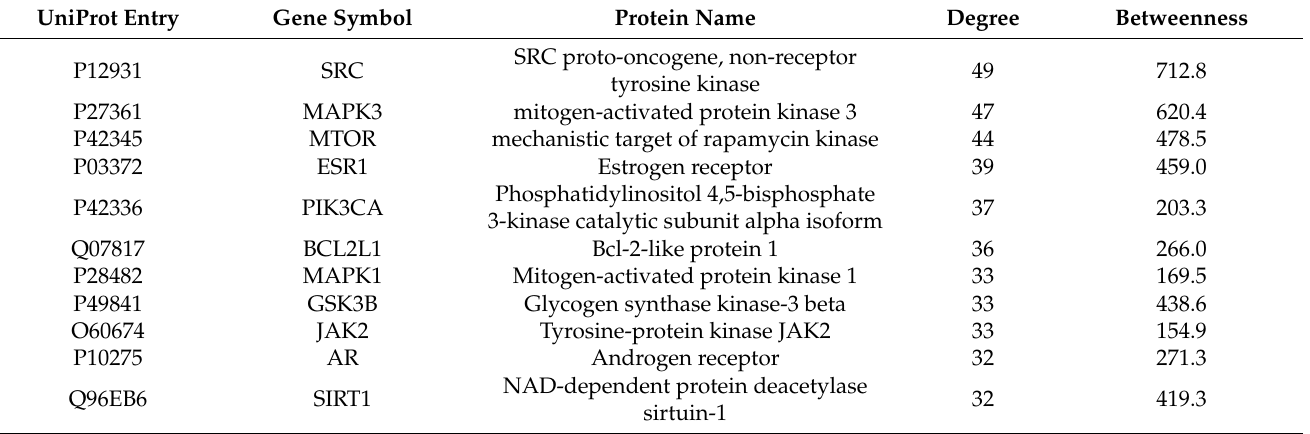
Figure 6. Protein − protein interaction network. Table 3. Network properties of the top 10 proteins with protein-protein interaction (PPI) network degree